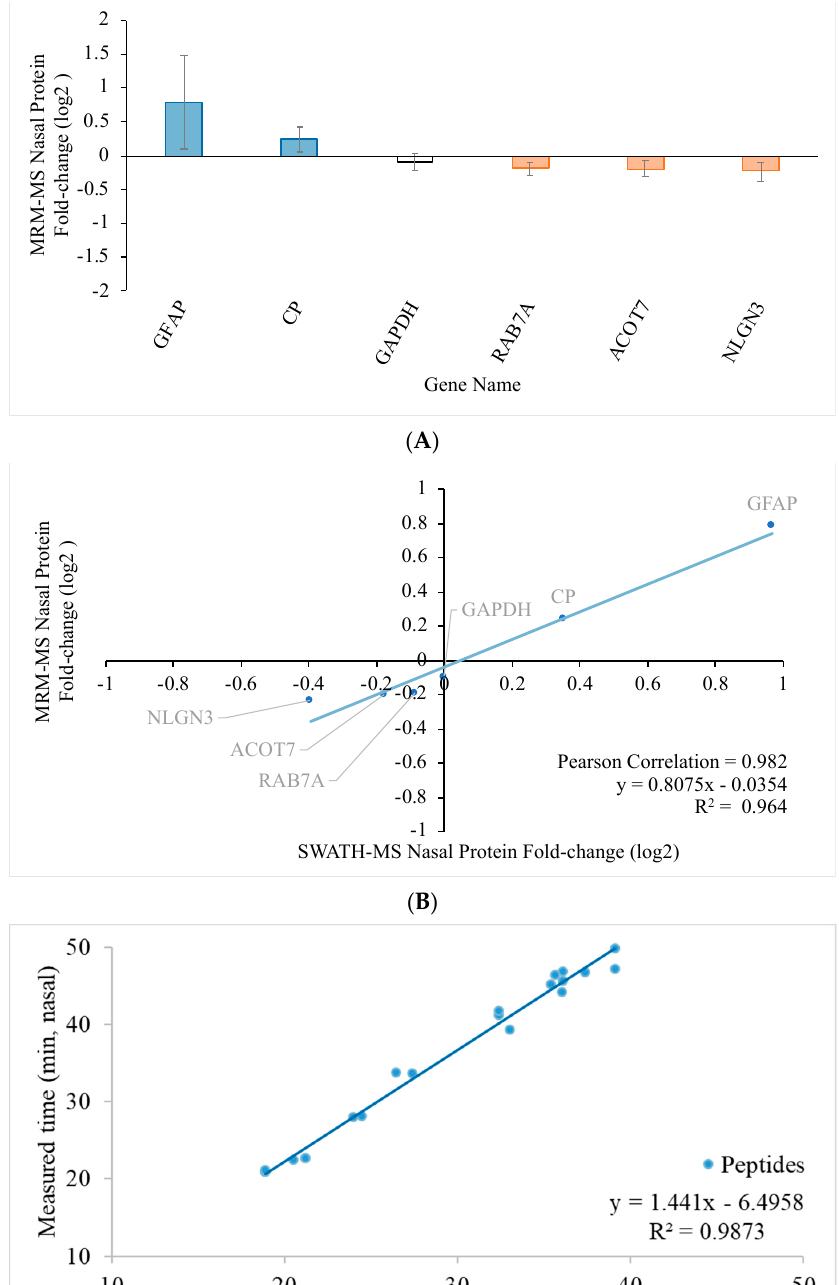
using independent MRM-MS and SWATH-MS experiments with high regression (R 2 = 0.965) and Pearson’s correlation (R 2 = 0.958) on differentially expressed proteome. GAPDH was included as a reference. ( C ) Retention time linear regression plot of total 99 MRM transitions, governing 33 peptides used for the identification and fold-change calculation of 11 temporal proteins ( n = 4, in triplicate).